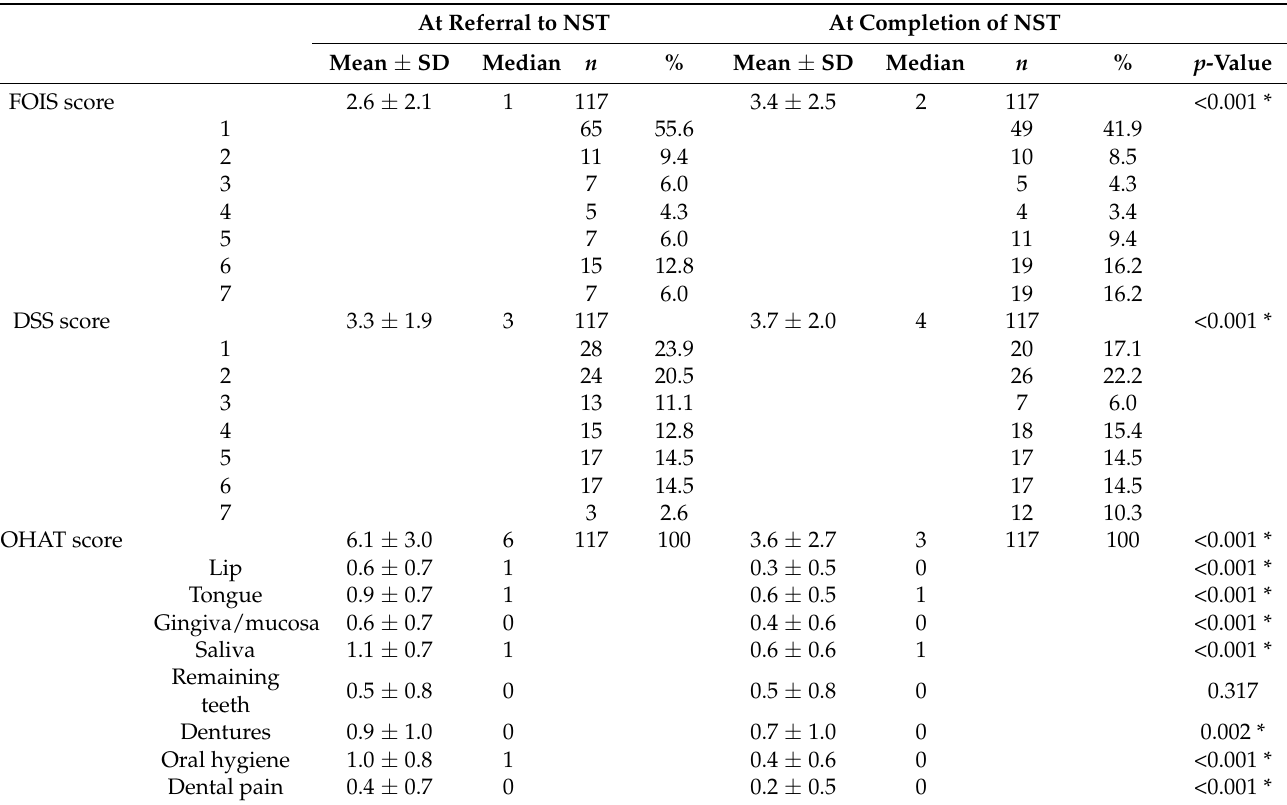
Table 2. Changes in the nutrition-intake method, swallowing ability, and oral environment elicited by NST intervention including multidisciplinary oral health